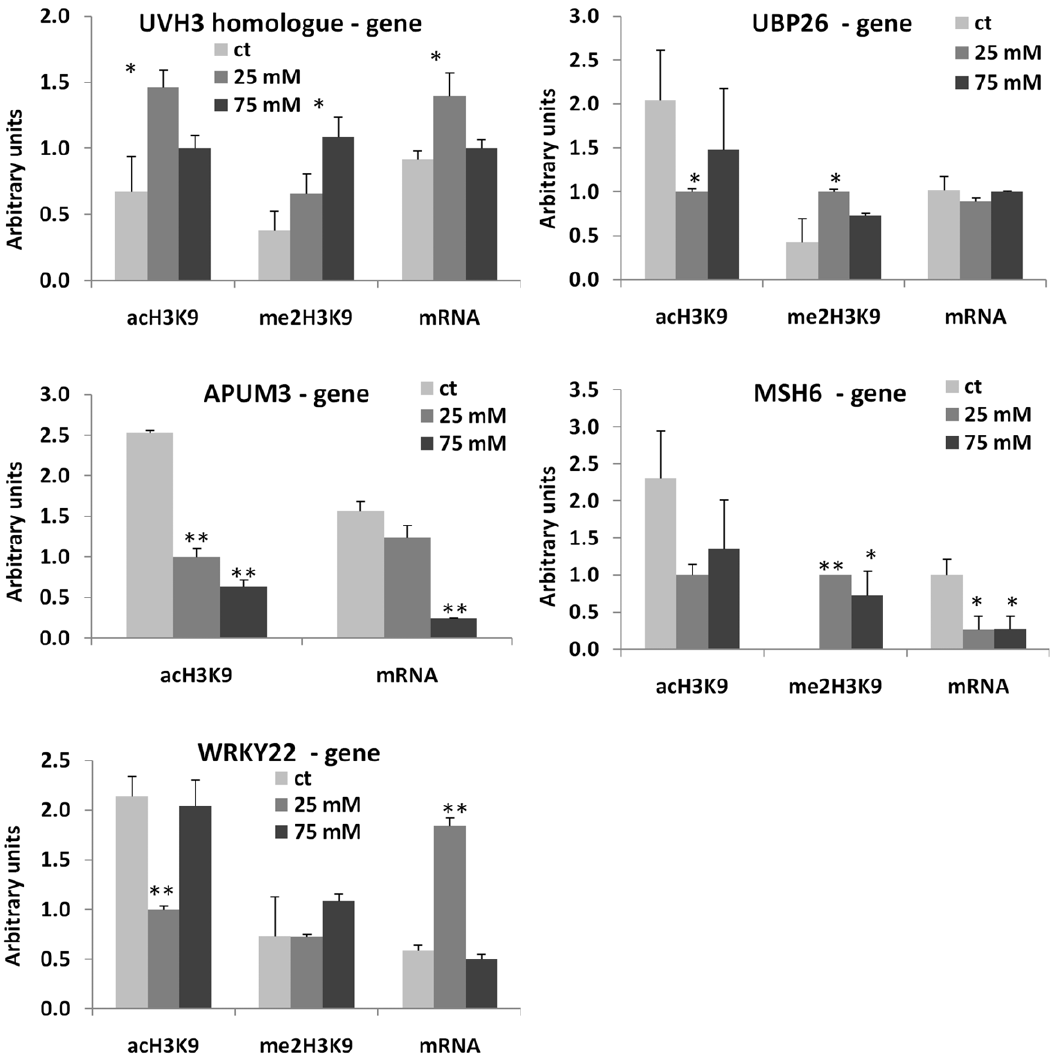
Figure 7. Histone modifications (H3K9me2 and H3K9ac) at the gene body regions of UBP26 , WRKY22 , MSH6 , UHV3homolog and APUM3 genes. The figure shows the levels H3K9me2 and H3K9ac observed at the gene body regions of WRKY22 , MSH6 , UVH3 homolog , MOS6 , APUM3 and UBP26 genes. Each figure also shows mRNA levels for each of the genes. The Y-axis shows the levels of mRNA expression and H3K9me2/ H3K9ac in average arbitrary units (calculated from three independent experiments with SD). The asterisks denote a significant difference between the progeny of stressed (25 and 75 mM) and control plants; one asterisk stands for p , 0.05 and two asterisks for p , 0.01.